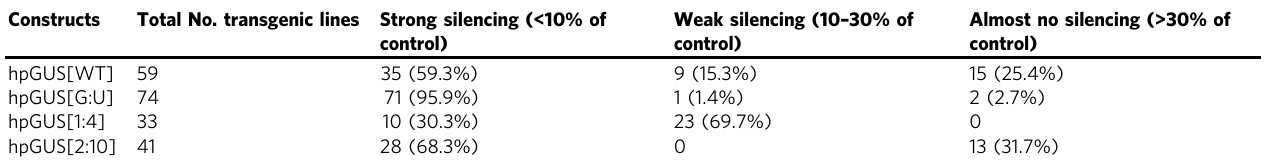
Table 1 Summary of GUS gene silencing by the four hpRNA constructs based on MUG assay data.